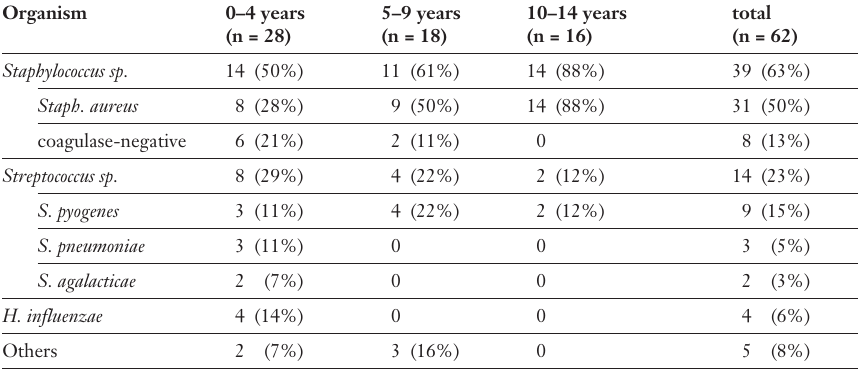
Prevalence of isolat- ed organisms by age of patients with acute haematogenous osteomyelitis and/or septic